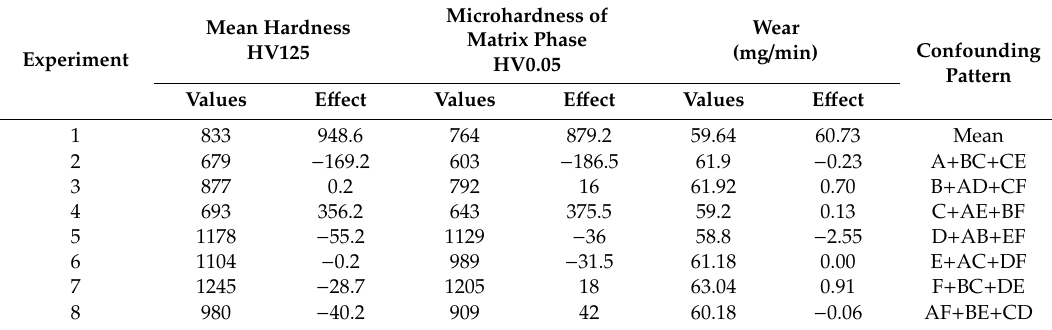
Table 5. Mean values and standardized effects for the analyzed parameters.